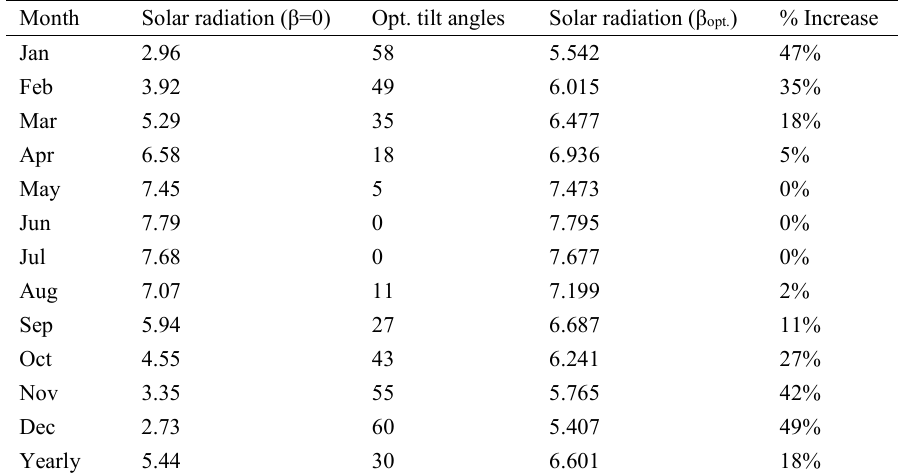
Figure 12. Effect of tilt angle on hourly annual solar Figure 13. Effect of tilt angle on monthly solar radiation. Table 6. Gain of solar radiation energy from tilting solar panels.